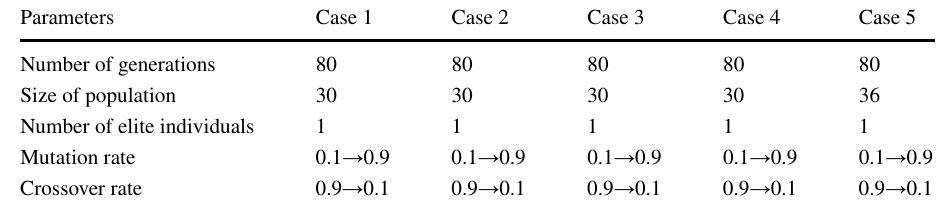
Table 5 Fast genetic algorithm parameters